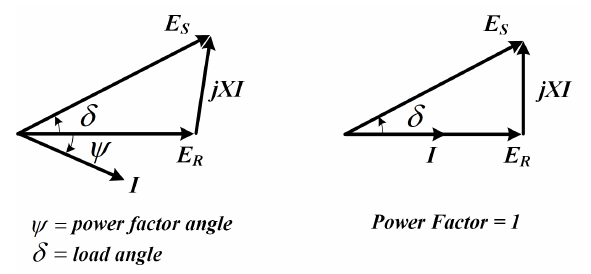
Figure 6. Phase diagram according to load angle and power factor